Question: Looking at the figure, what chart type is it?
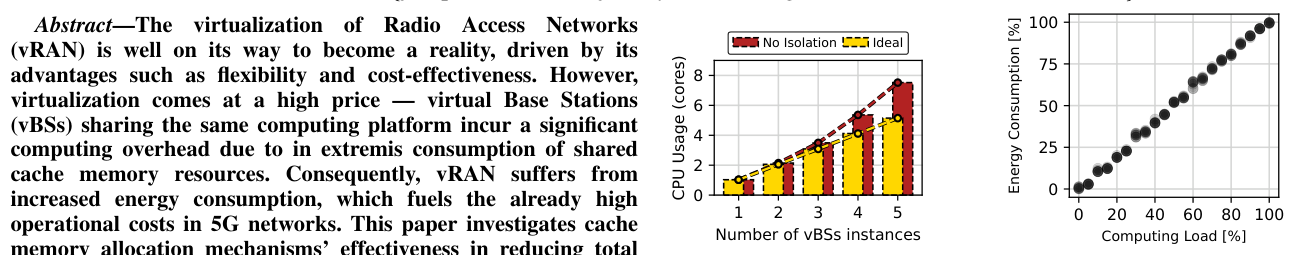
Answer: line